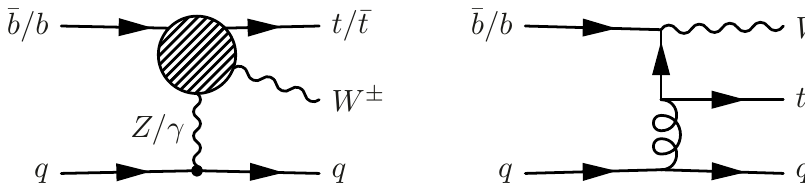
Figure 6. Left : schematic Feynman diagram for the EW-induced tWj process and its embeddings of the b W t Z and b W t Z subamplitudes. Right : sample Feynman diagram for the ! !